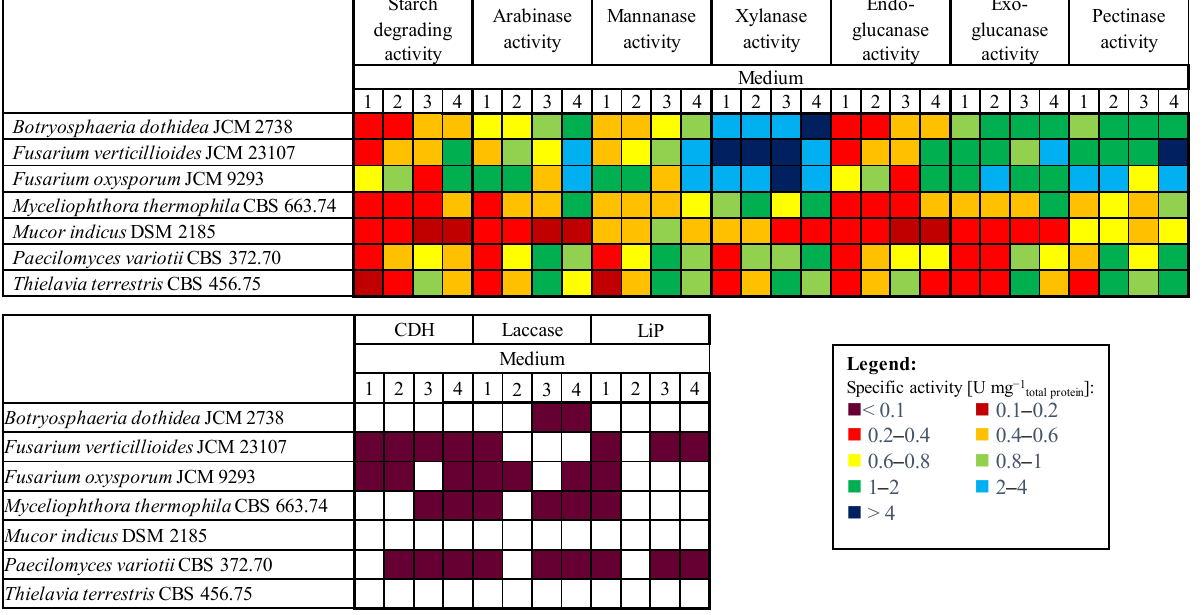
Figure 1. Screening of lignocellulolytic (and starch) enzyme degrading activity by different fungi in various media. M. thermophila CBS 663.74, P. variotii CBS 372.70, and T. terrestris CBS 456.75 showed some degree of enzyme activities, which were 2 to 10 times lower compared to those of F